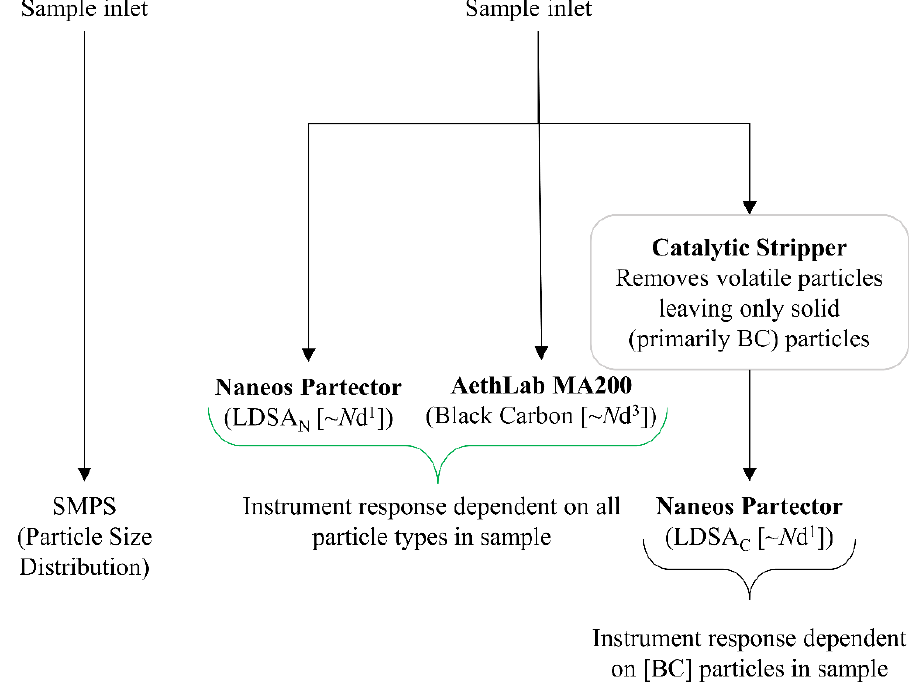
Figure 2. Instrument suite diagram for the data collection and the particle characteristic each instrument measures.